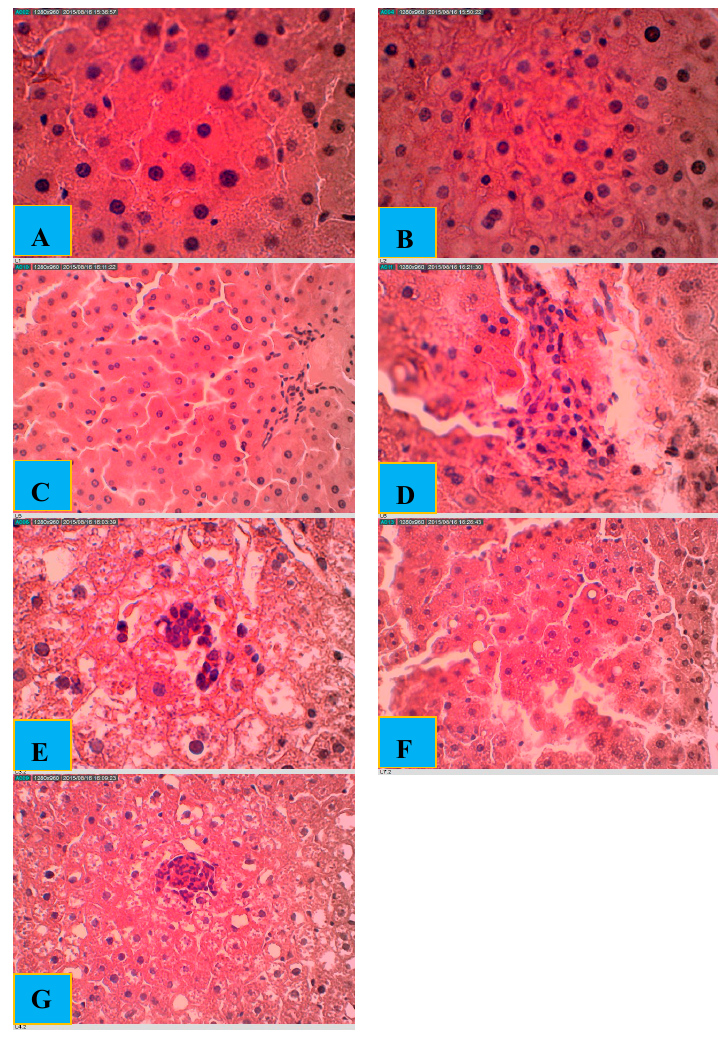
Figure 4. Histological examination of rat livers stained with hematoxylin and eosin (H&E). ( A ) Control: showing liver tissue with normal architecture; ( B ) PI 200ND: showing liver tissue with normal architecture; ( C ) PI 400ND: showing liver tissue with normal architecture; ( D ) STZ: showing expanded portal tracts by a severe lymphocytic infiltrate associated with necrotic hepatocytes focally; ( E ) STZ I: showing liver tissue with a mild lymphocytic infiltrate present within the portal tracts ( F ) STZ PI 200: showing the presence of very mild lymphocytic infiltrate within the portal tracts and the lobules, with mild focal necro-inflammatory changes; ( G ) STZ PI 400: showing regenerative changes within the hepatocytes even though there are very mild necro-inflammatory foci. (Scale bar = 310 µ